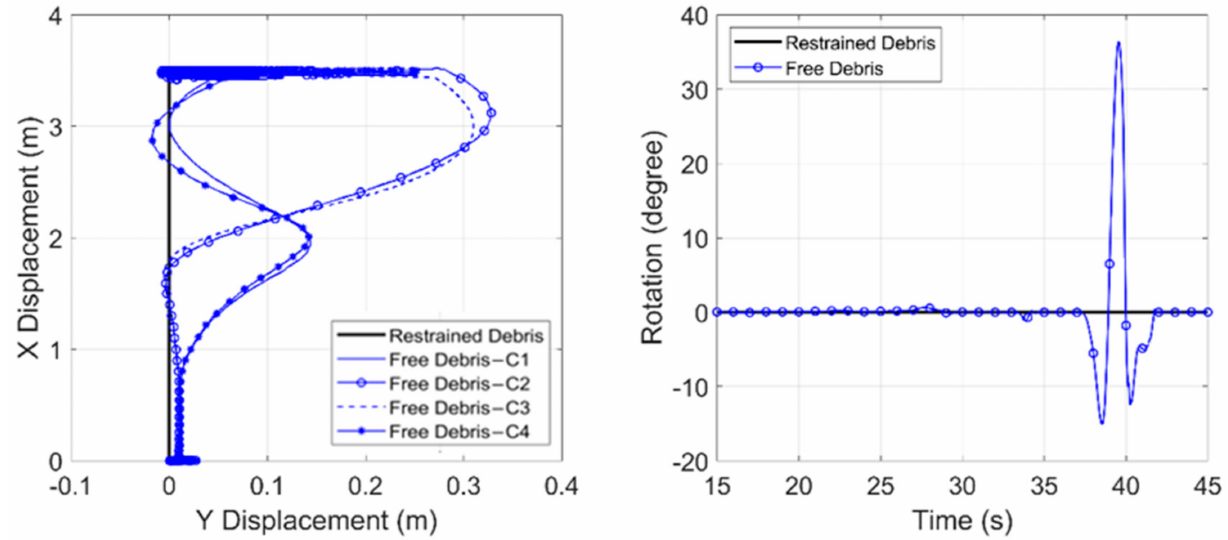
Figure 10. Debris trajectory ( left ) and rotation ( right ) for the restrained debris and free debris. Numerical results for the hydrodynamic case with h 1 = 2.496 m, and h 2 = 0.13 m and T erf = 30